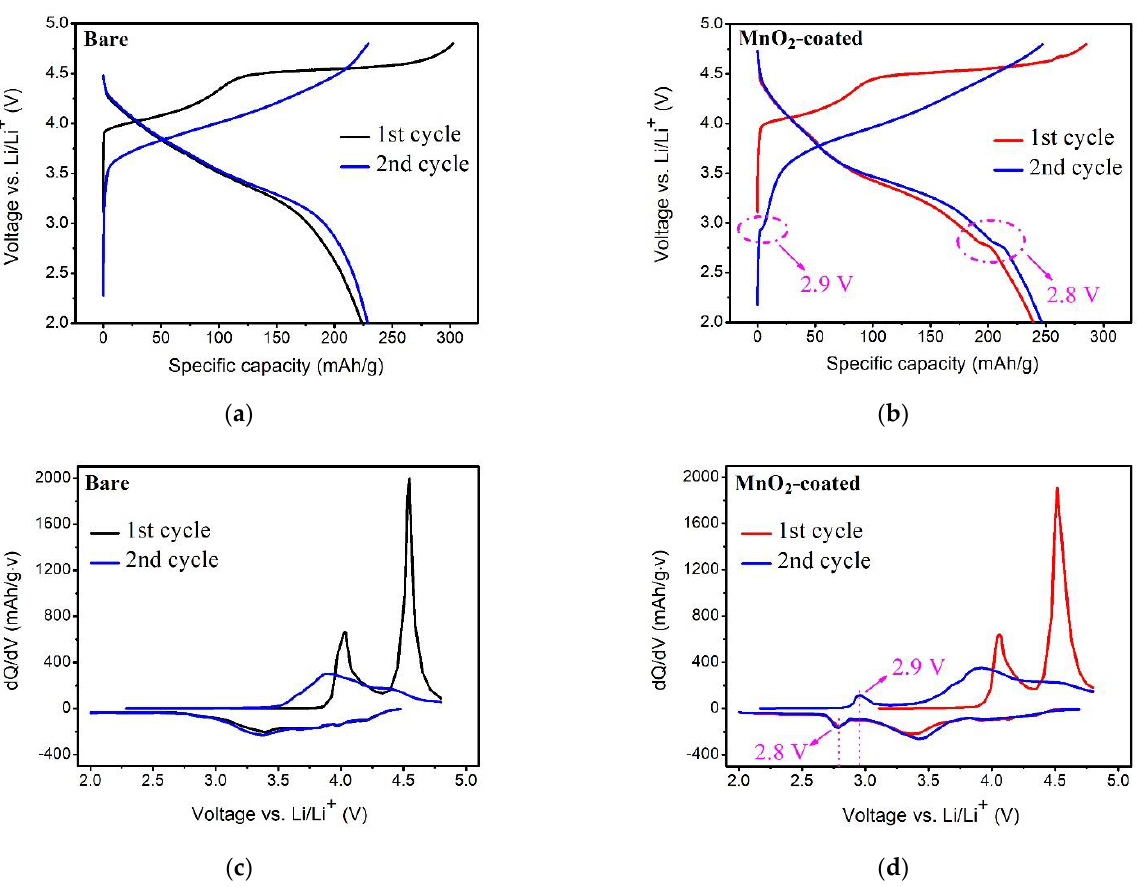
Figure 5. The electrochemical characteristics of the bare and MnO 2 -coated LTMO at 0.05 C. ( a , b ) Charge and discharge curves and ( c , d ) dQ/dV profiles.